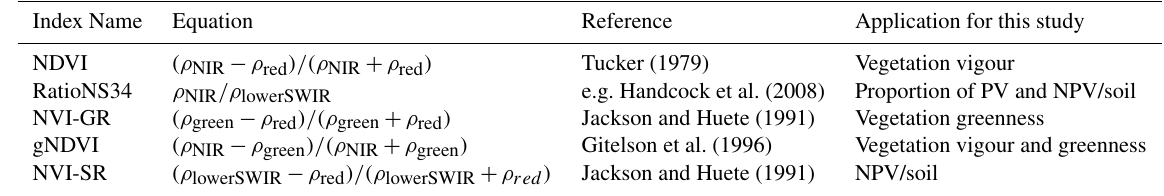
Table 1. Vegetation indices calculated from the multispectral sensor data. ρ = reflectance (0 to 1).